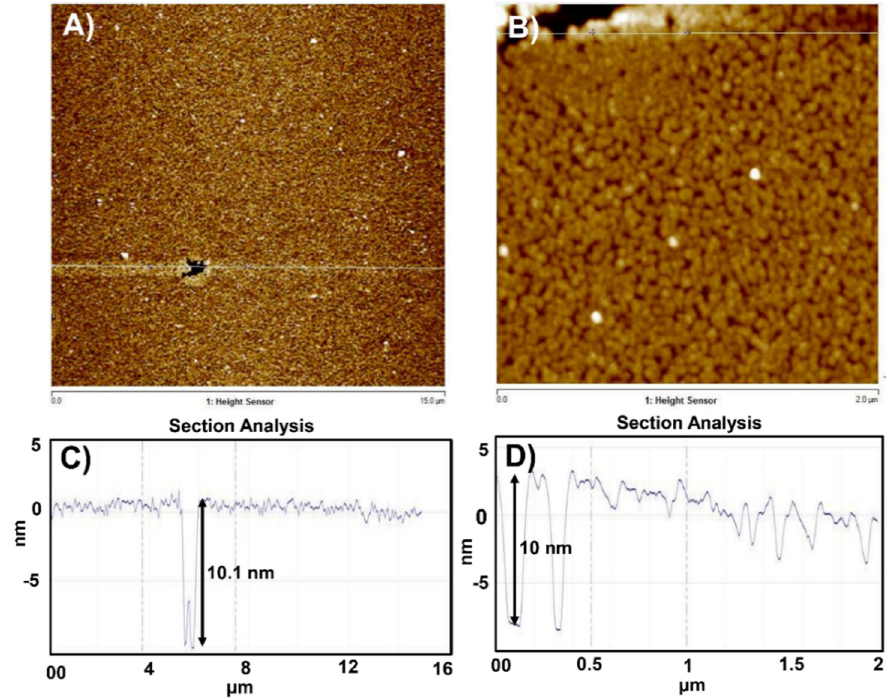
Figure 5. Surface morphology of the Fe 3 O 4 nanoparticle monolayer formed over the Al 2 O 3 monolayer film. ( A ) Low-magnification (15 µm × 15 µm) and ( B ) high-magnification (2 µm × 2 µm) AFM images of the Fe 3 O 4 nanoparticle monolayer. Height cross-sectional profiles corresponding to ( C ) image A and ( D ) image B.